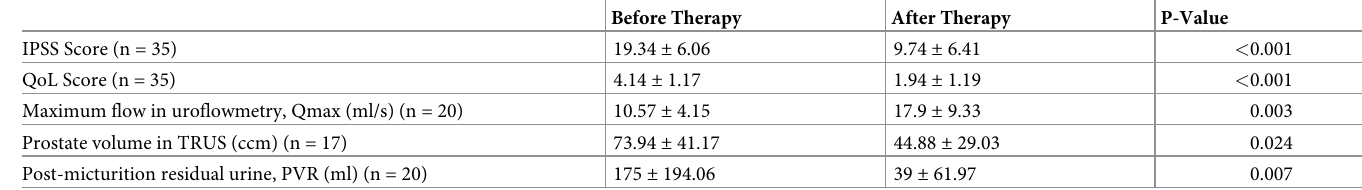
Table 2. Patients’ characteristics before and after treatment. Values are mean ± standard deviation (SD). Mean follow-up: 137 ± 55 days. IPSS = International Prostate Symptom Score. QoL = IPSS Quality of Life Score. TRUS = transrectal sonography of the prostate.